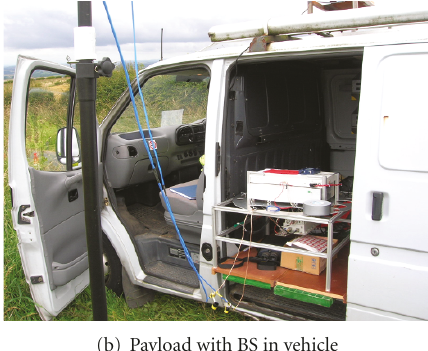
Figure 3: A remote, portable WiMAX test rig.